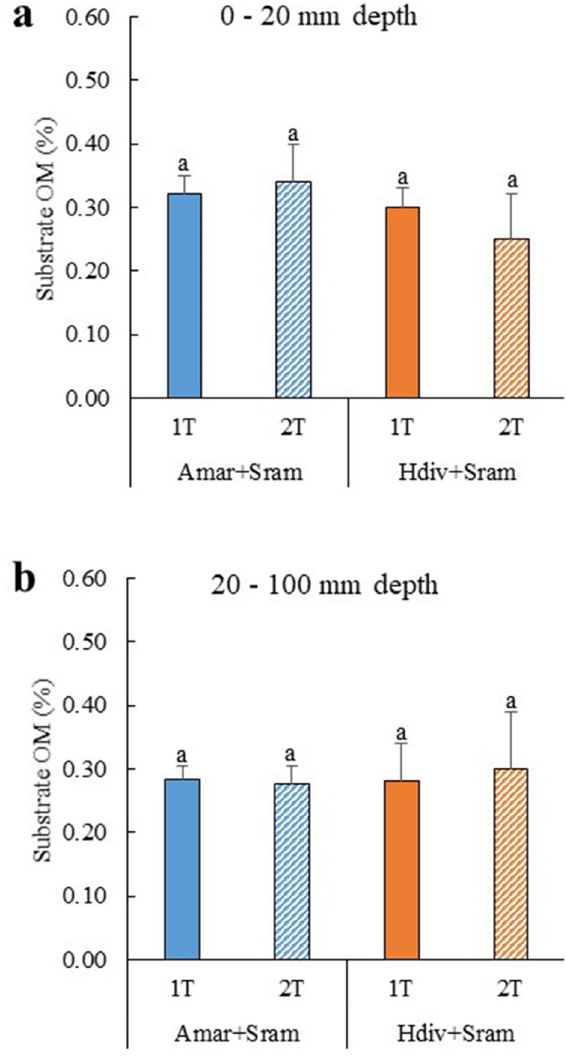
Figure 2. Organic matter (OM) content determined in the top 20 mm and 20–100 mm substratum layers of IMTA designs tested in the present study using as extractive species polychaetes ( Arenicola marina —Amar— and Hediste diversicolor —Hdiv) and halophytes ( Salicornia ramosissima —Sram) cultured in the same tank (1 T) or in two separate tanks (2 T). Average values ± SD (n = 5). No significant differences ( p < 0.05) between IMTA designs were observed.